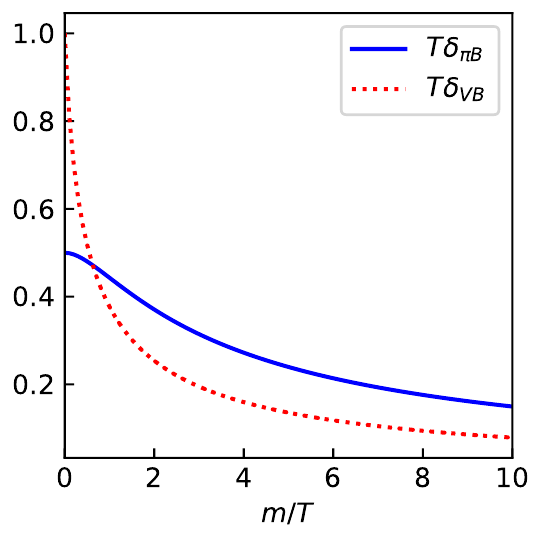
Figure 1 . Dimensionless transport coefficients Tδ V B and Tδ πB that couple fluid to magnetic field as a function of m/T